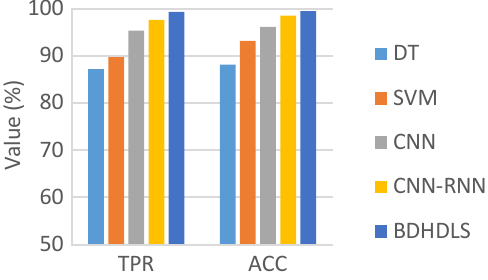
Fig. 12 TPR and ACC for CICIDS2017 dataset.